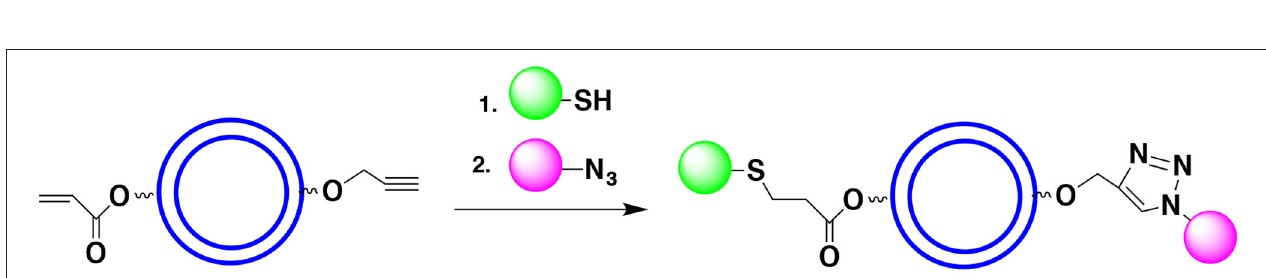
FIGURE 13 | The use of various hydroxyl protective groups. Gradual deprotection of single protective groups followed by introduction of selected surface moieties.